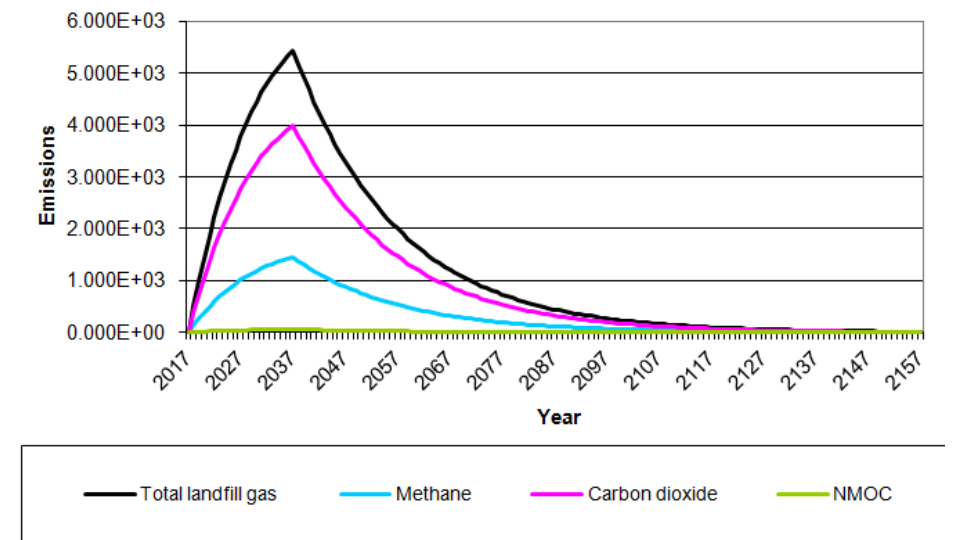
Fig 2. The amount of generated gas, methane, and carbon dioxide and NMOC, Chaharmahaal and Bakhtiari